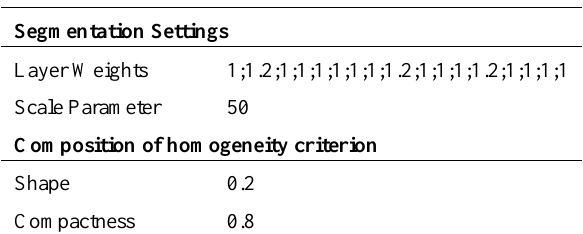
Table 2. Quantitative analyses of the Sentinel-2